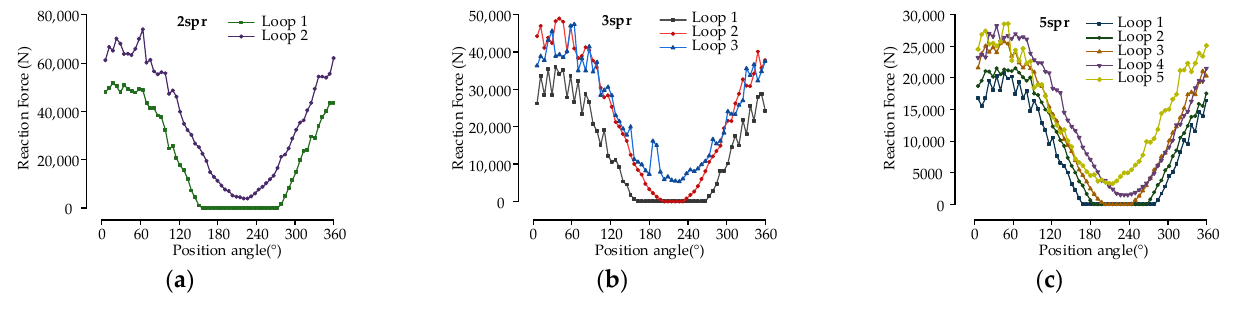
Figure 21. Spring reaction force in different cases. ( a ) Spring reaction force of 2 spr; ( b ) Spring reaction force of 3 spr; ( c ) Spring reaction force of 5 spr.